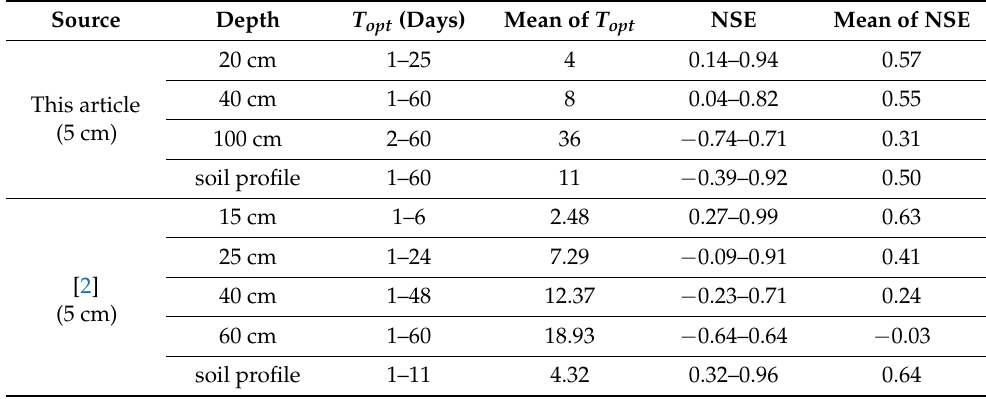
Figure 5. NSE between SWI o and SWI m at the depths of 20 ( a ), 40 ( b ), 100 cm ( c ) and for the profile average value ( d ). SWI o standardized by daily volumetric soil moisture at the depth of 5 cm is used to estimated SWI m at the depths of 20 cm, 40 cm, 100 cm and for the profile average value. Each color represents a station. Table 1. Statistics of the characteristic time length T opt using near-surface SWI to predict SWI at various root zone depths and corresponding NSE